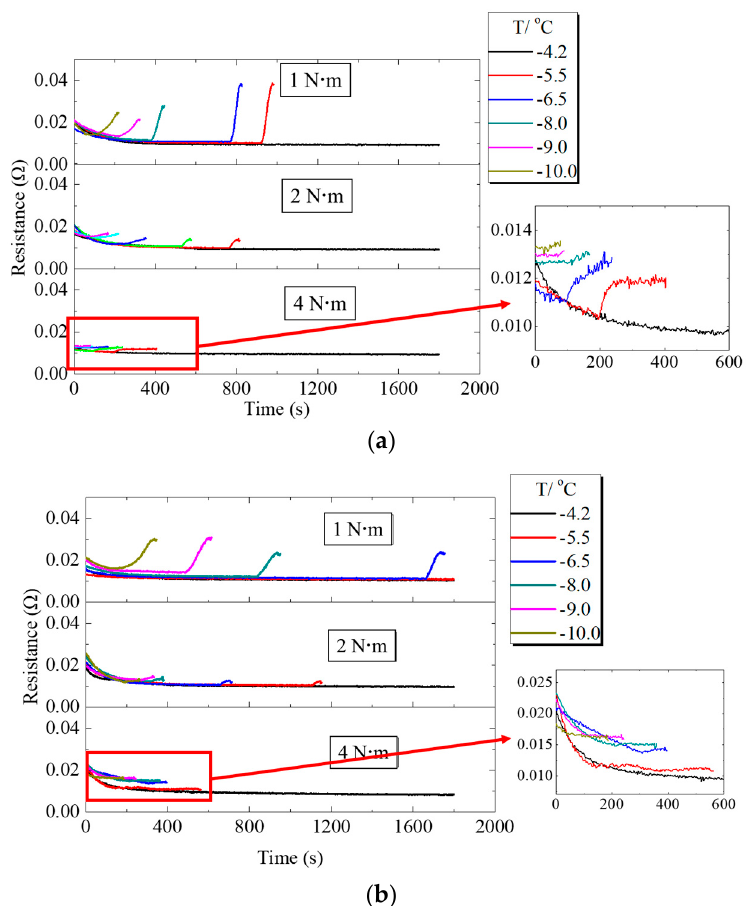
Figure 8. Ohmic resistance changes of PEMFC under different assembly pressures: ( a ) Ohmic resistance changes of PEMFC with C-MPL & GDL; ( b ) Ohmic resistance changes of PEMFC with H-MPL & C-GDL.